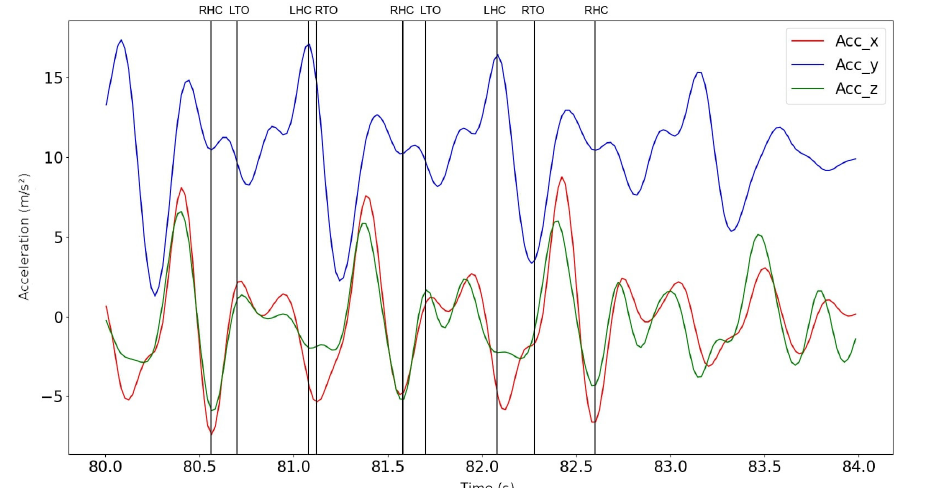
Figure 5. Gait Cycle Detection Example. Each gait cycle is between two consecutive right heel contact (RHC)